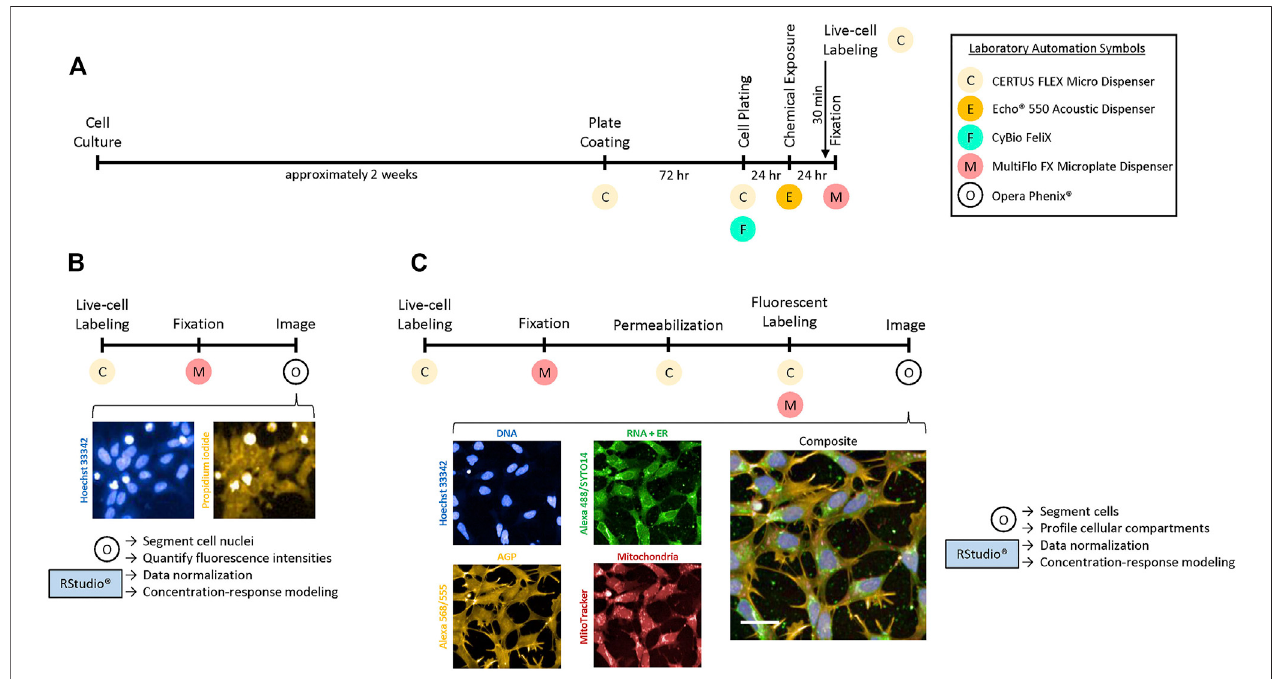
FIGURE 1 | Experimental design for HTPP in hNP1 cells. (A) Timeline to prepare cells for the Cell Viability [CV; (B) ] or Cell Painting [CP; (C) ] assay. The live-cell labels were added 30 min prior to the end of the 24 h chemical exposure period. Necessary laboratory automation is denoted below each process. Images were captured with a 10X air or 20X water immersion objective for the CV or CP assay, respectively. Harmony ® software was used to processthe images and Microsoft PowerPoint to crop and enlarge distinct areas. The cell- or well-level data obtained from the images were then exported for downstream analysis with R statistical software.